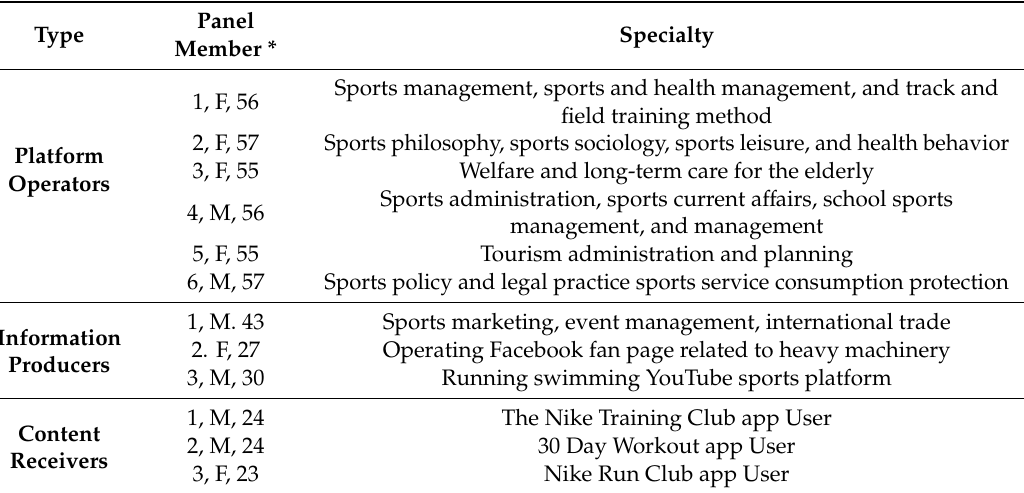
Table 1. The Background of Panel